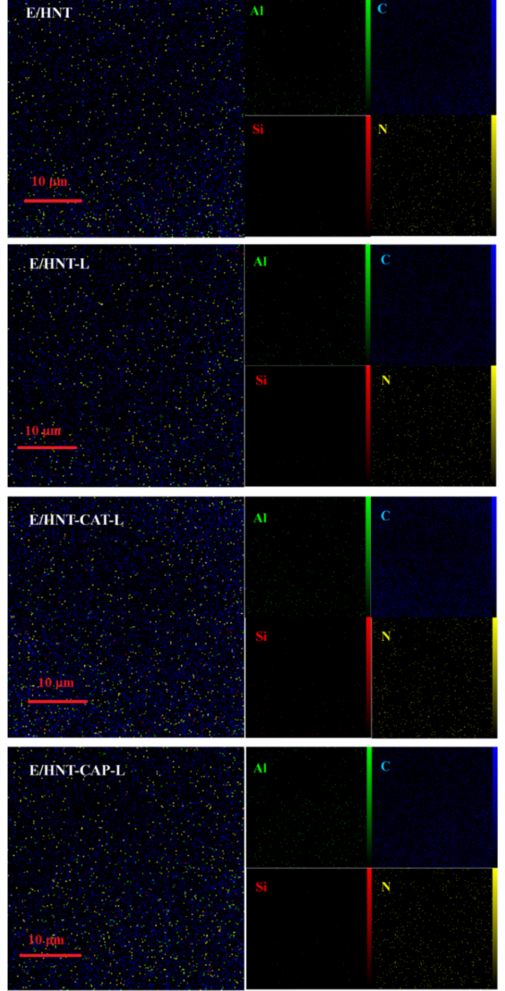
Figure A1. Mapping analysis of E/HNT, E/HNT-L, E/HNT-CAT-L, and E/HNT-CAP-L